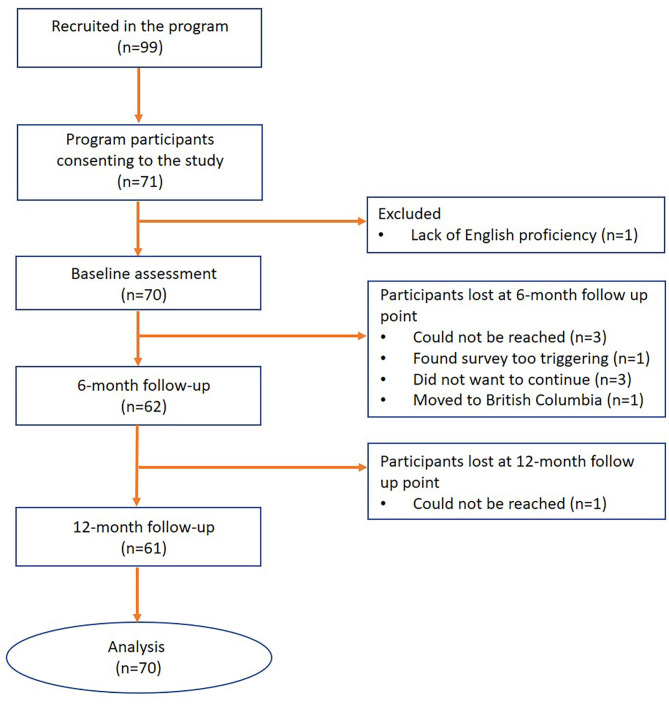
Study flowchart.